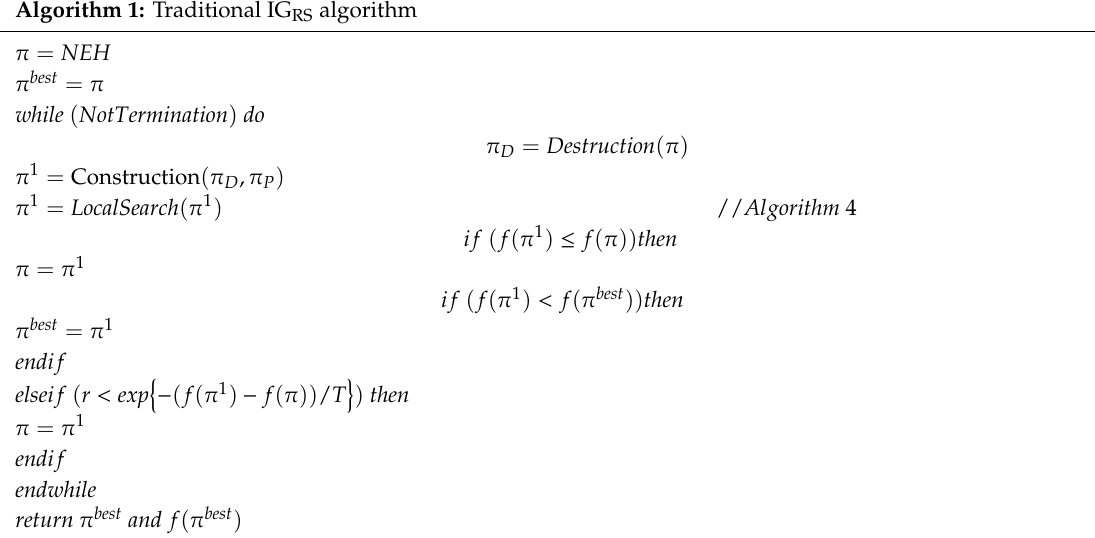
Algorithm 1: Traditional IG RS